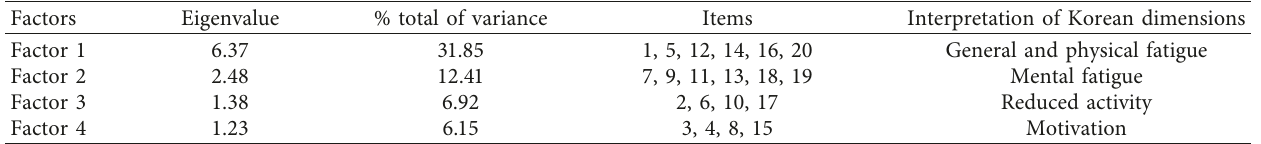
Table 2: Principal component analysis after varimax rotation of MFI Korean